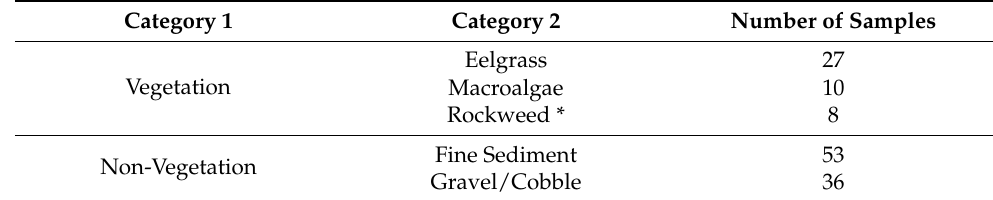
Table 1. The number of in situ samples for different habitat types.